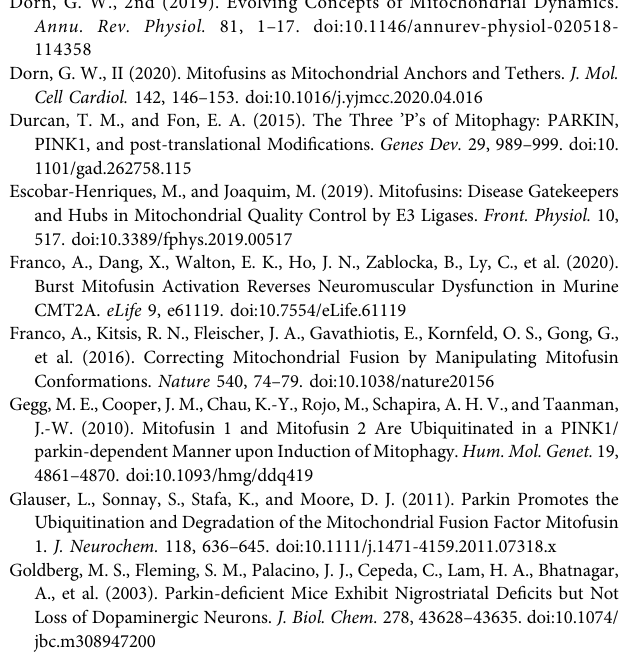
Supplementary Figure S1 | Parkin is recruited to mitochondria upon FCCP treatment of WT MEFs. Left panel: at baseline, mcParkin (Mayer et al) appears diffusely cytosolic, and the mitochondrial have normal morphology (green). Right panel: after FCCP treatment (5 µM, 1 hour), Parkin translocates to mitochondria, forming visible aggregates. Also note mitochondrial fragmentation after FCCP. Supplementary Figure S2 | Mitochondrial mitolysosome formation in cells lacking different mitophagy factors. This fi gure is an expanded version of representative mitoQC images from Figure 4 . (A,B) wild-type (WT). (C,D) Mfn1/2 DKO, (E,F) Pink1 KO or (G,H) Prkn KO MEFs. (A,C,E,G) , basal condition. (B,D,F,H) , FCCP treated condition. Left panels are red images from mitoQC mCherry signal, middle panels are green images from mitoQC EGFP signal, right panels are merged mitoQC